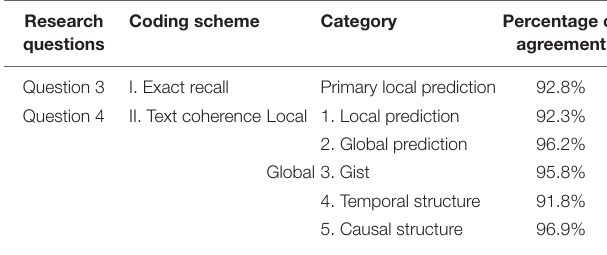
TABLE 8 | Inter-rater reliability for coding of accurate recall and text coherence ( n =